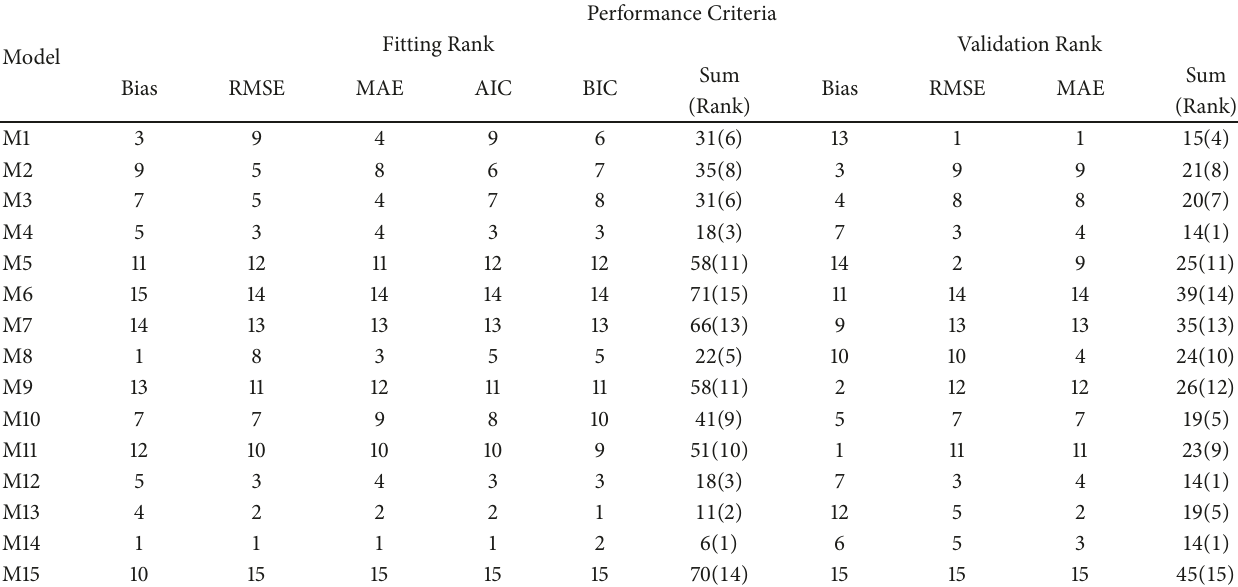
Table 5: Rank of selected models based on performance criteria for fitting and validation